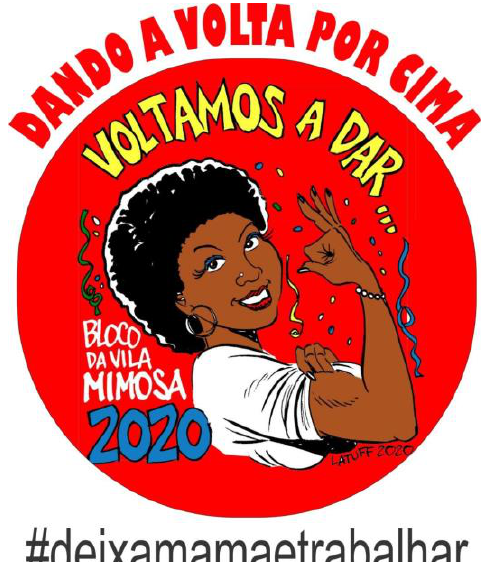
Figure 1. Vila Mimosa bloco artwork. “Turning things around”, “We’re back putting out”, #letmommywork. Downloaded from Amocavim’s Facebook page.